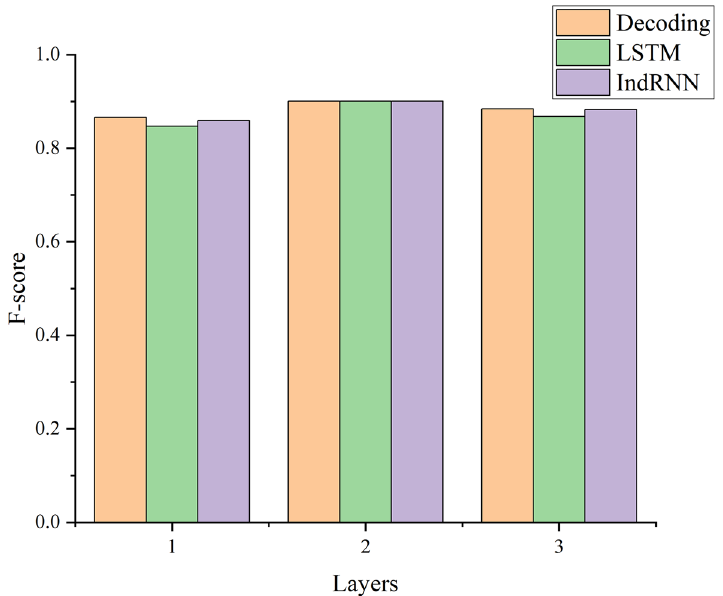
Figure 6. Effect of the number of coding and decoding layers on the